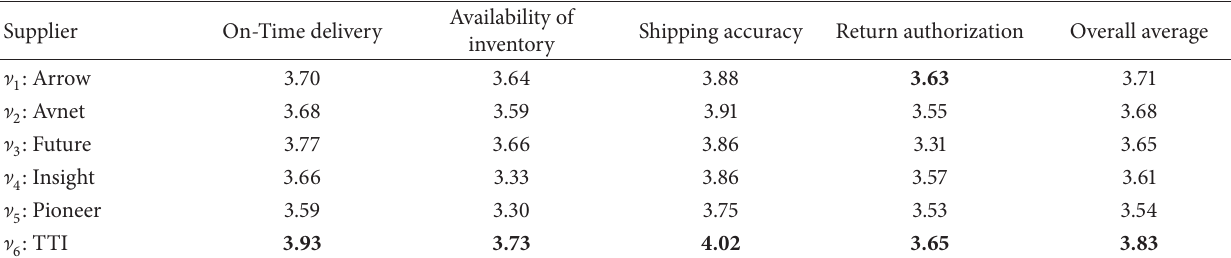
Table 8: Fuzzy scores for all suppliers on all attributes of the delivery criterion, dataset of all 406